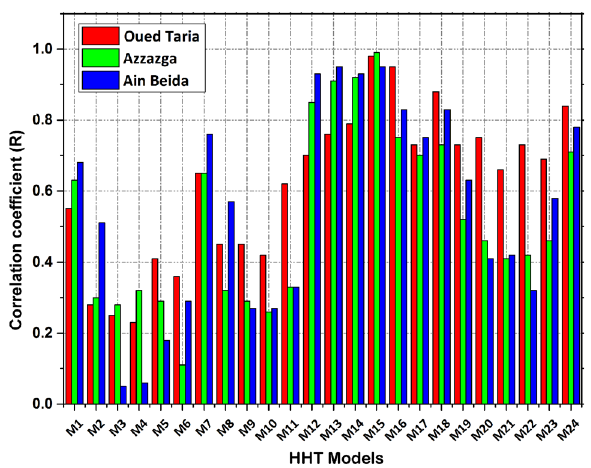
Fig. 6 Cor rel ation coefficient between each pro pos ed model resulting f rom Hi lbert Huang transform and t he ori gin al rainfall